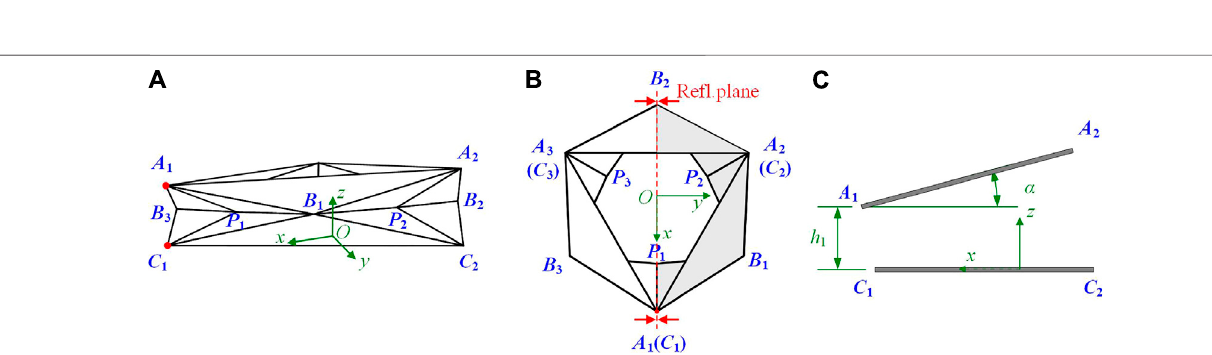
FIGURE 3 | Kinematics of a single-layer Yoshimura-ori structure with virtual creases. (A) Introduction of virtual creases to account for facet bending. With virtual creases, panels A